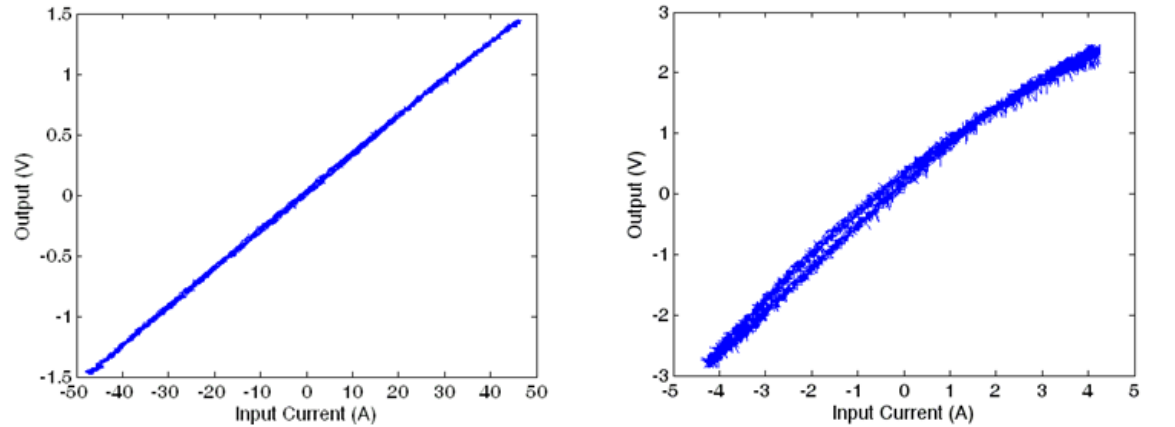
Figure 7. Linearity of the current sensor ( a ) with Helmholtz coil and; ( b ) without Helmholtz